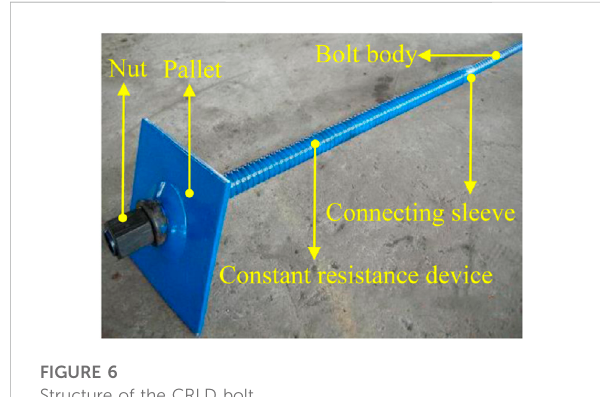
FIGURE 6 Structure of the CRLD bolt.